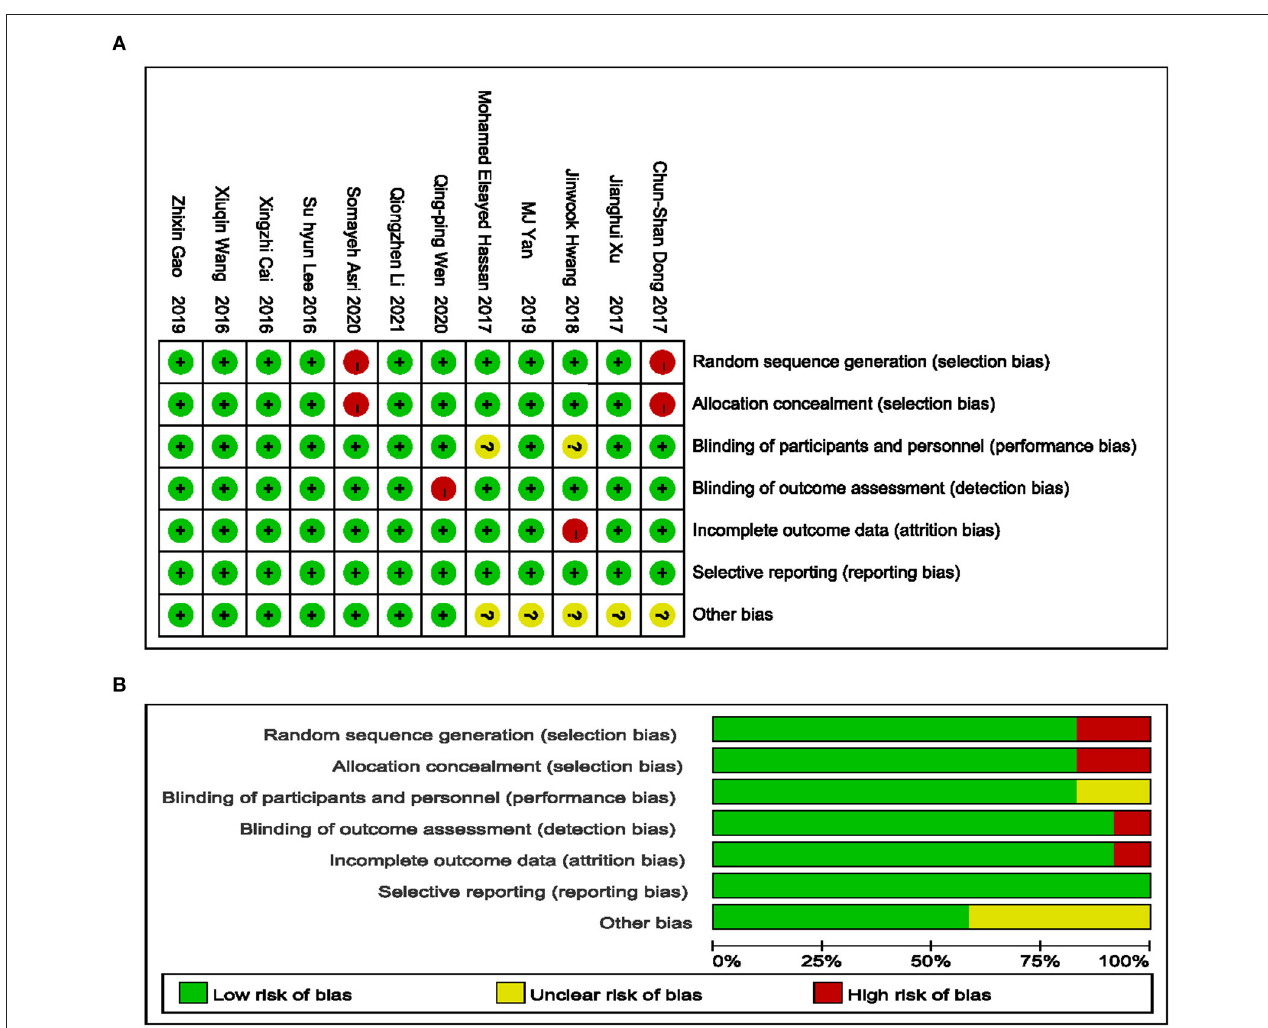
FIGURE 2 | Risk of bias summary. Green low risk, yellow unclear risk, red high risk (A) ; Green low risk of bias, yellow unclear risk of bias, red high risk of bias (B) .